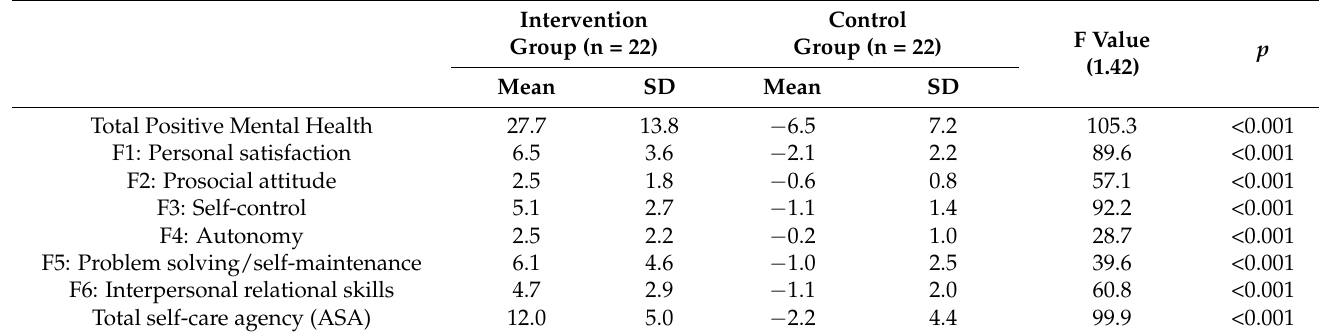
Table 3. Pretest–posttest: differences in positive mental health and self-care